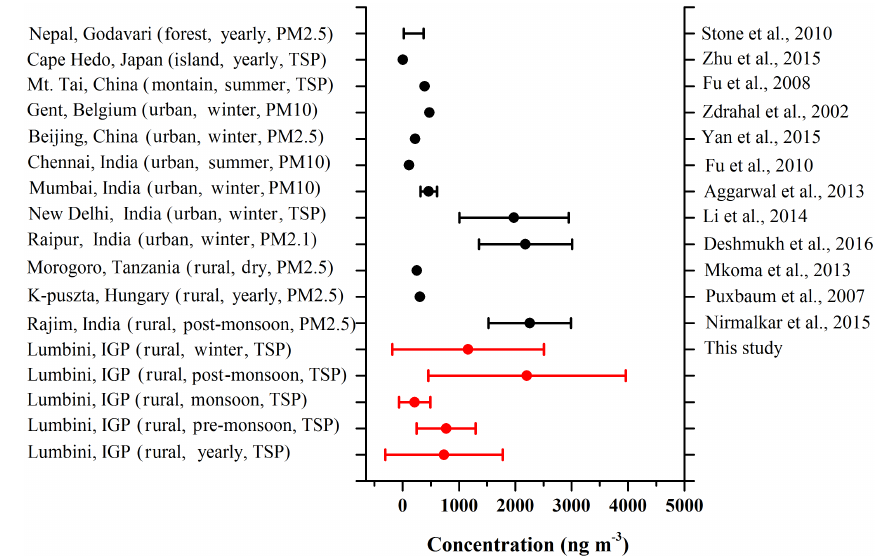
Figure 5. Comparison of levoglucosan concentrations in Lumbini with other sites in different locations worldwide.